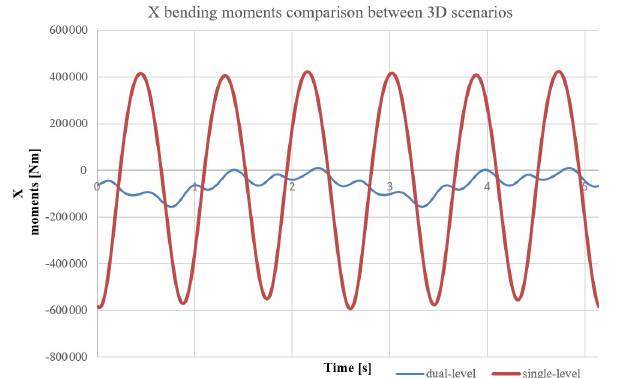
Figure 9. Bottom side view of select mesh parts.